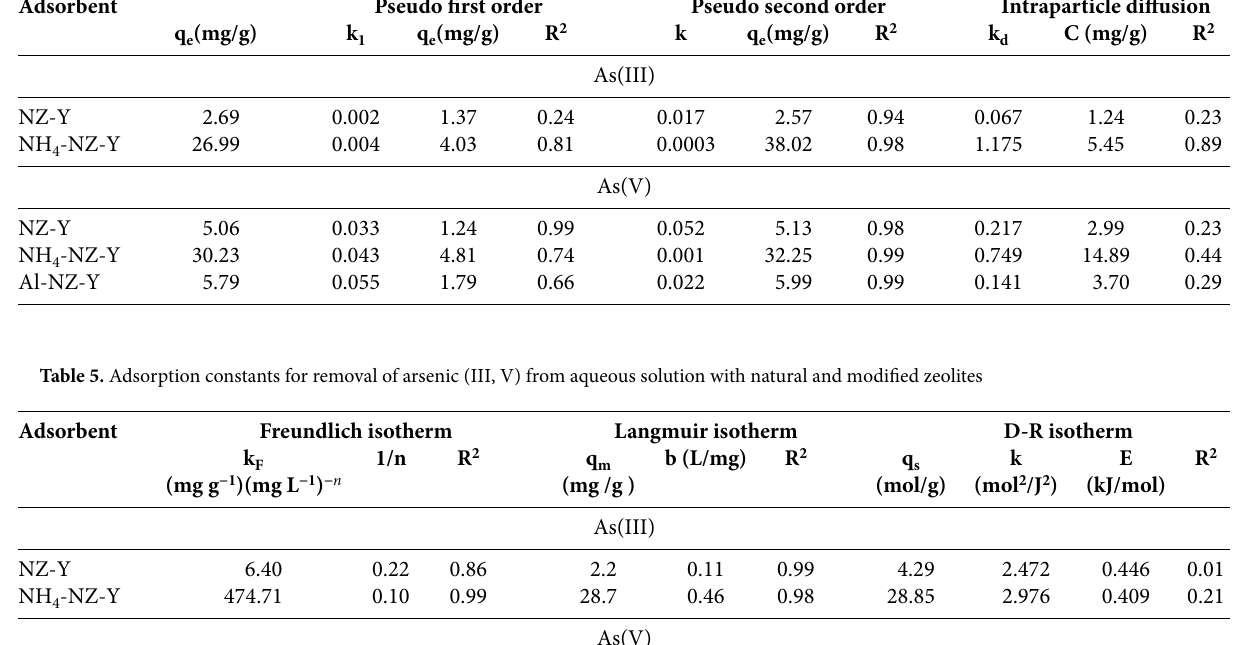
Table 4. Kinetic parameters for adsorption of As (III&V) by NZ-Y, NH4-NZ-Y and Al-NZ-7 in water. Adsorbent Pseudo first order Pseudo second order Intraparticle diffusion